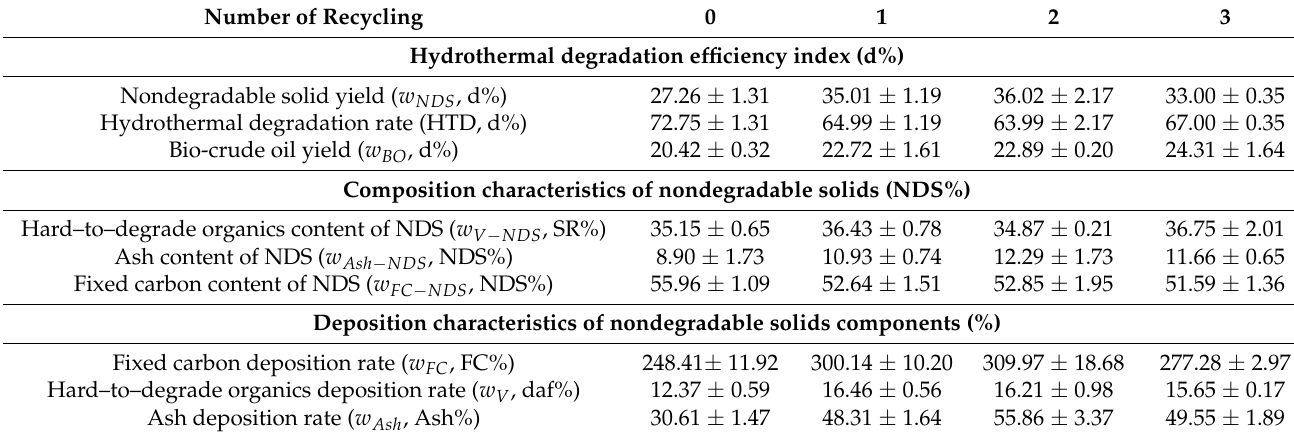
Table 4. Effect of aqueous phase recycling on the overall characteristics of hydrothermal